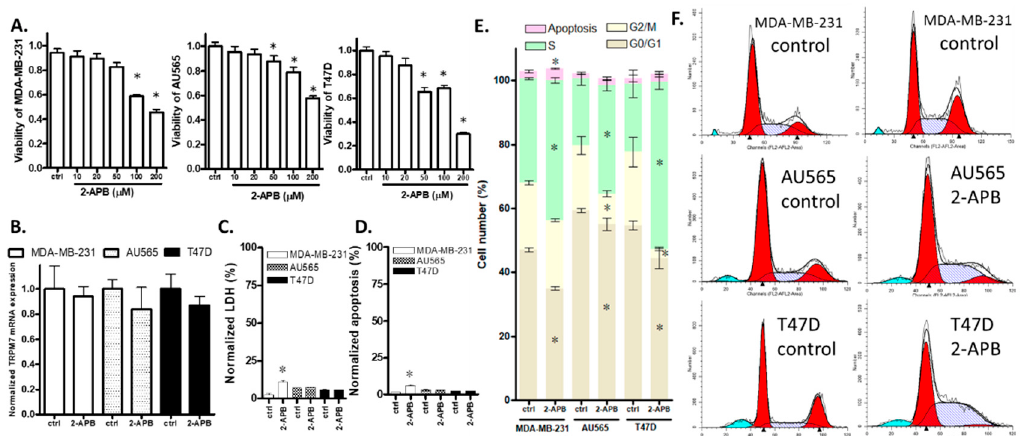
Figure 5. Effects of 2-APB on breast cancer cell lines. ( A ) Cell viability. The 24-h treatment with 2-APB (50–200 µM) significantly suppressed viability in all three cell lines except for 50 µM 2-APB on MDA-MB-231. ( B – E ) show data for cells exposed to 200 µM 2-APB for 24 h. ( B ) TRPM7 mRNA levels. 2-APB did not significantly affect TRPM7 mRNA expression. ( C ) LDH release. 2-APB had a significant effect on the LDH of MDA-MB-231 only. ( D ) Apoptosis. 2-APB had a significant effect on the apoptosis of MDA-MB-231 only. ( E ) 2-APB caused an increase in the percentage of cells in the S phase and a corresponding decrease in cells in the G0/G1 phase in all three cell lines and also caused a decrease in the number of cells in the G2/M phase in AU565 and T47D. ( F ) Representative images from the cell cycle assay of breast cancer cell lines. Significant differences ( p < 0.05) from control are indicated by “*”.